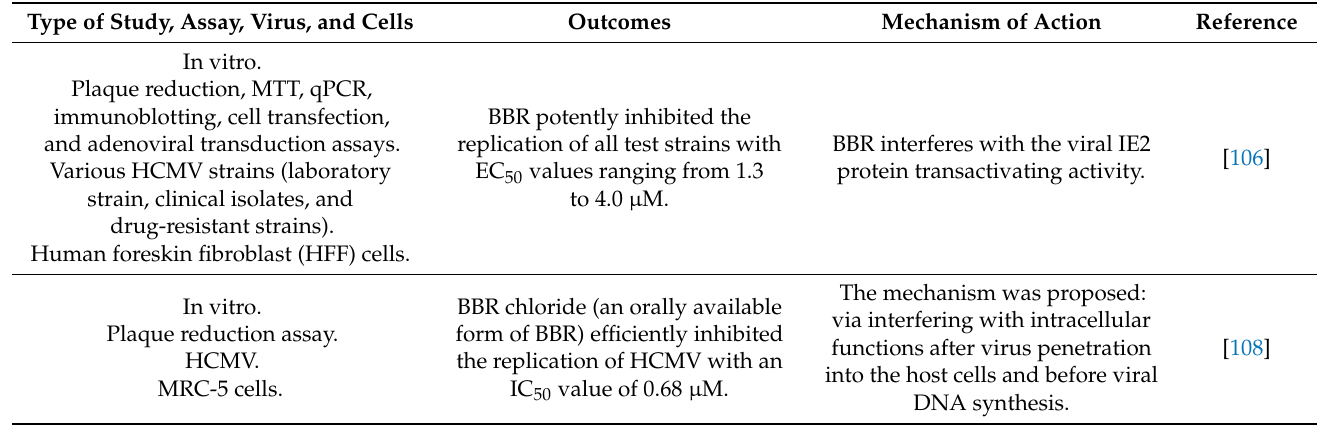
Table 3. Antiviral effect of berberine against human